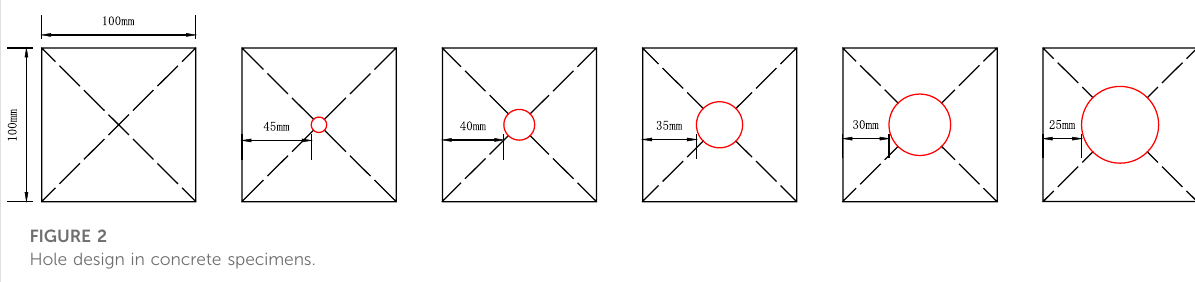
Hole design in concrete specimens.